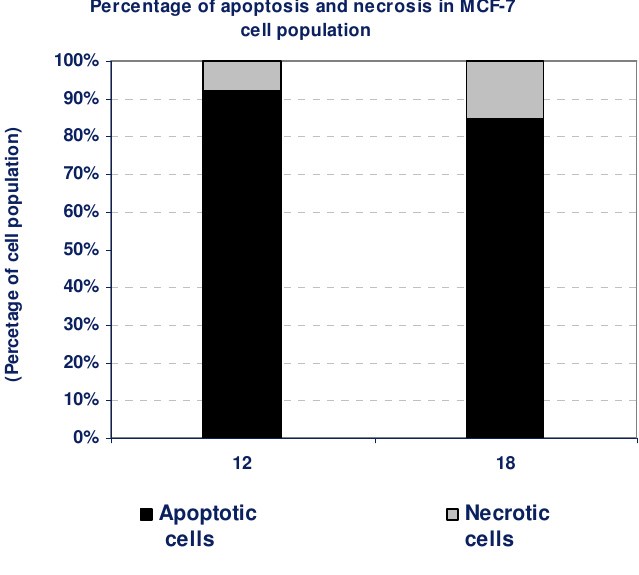
Figure 5. The type of cell death was investigated in MCF-7 cells after the treatment with the promising cytotoxic compounds, using acridine orange/ethidium bromide staining to compare between the percentage of necrotic cells (grey segment) and the apoptotic cells (black segment). Data are representing mean value ±